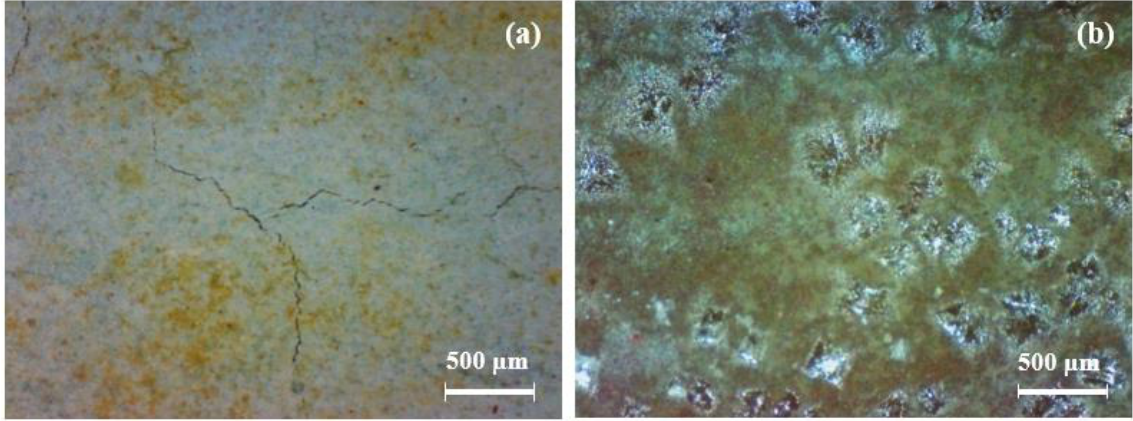
Figure 2. Photos of ( a ) FW1 and ( b ) FW2 coating surface after immersion for 1700 d by a portable video digital microscope.